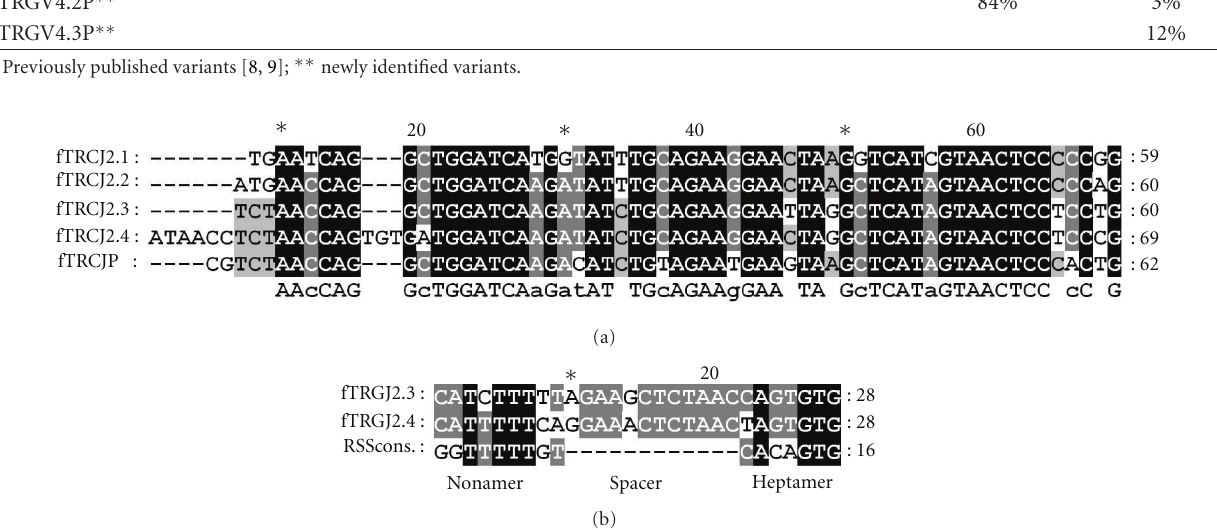
Figure 2: (a) Alignment of feline fTRGJ2-variants. In fTRGJ2.4 a three-base pair long insertion is present near the 3 (cid:2) end. The consensus sequence is given below the original sequences. (b) Alignment of 12RSSs belonging to fTRGJ2 variants and the consensus sequence (RSScons.) [6]. In fTRGJ2.4 the potential heptamer of the RSS created by an insertion of “TGT” (5 (cid:2) -CAG TGT G-3 (cid:2) ) is more similar to the consensus sequence than the original one. The mutation of the first residue (C → T) results in an alteration of the essential “CAC” sequence [17].